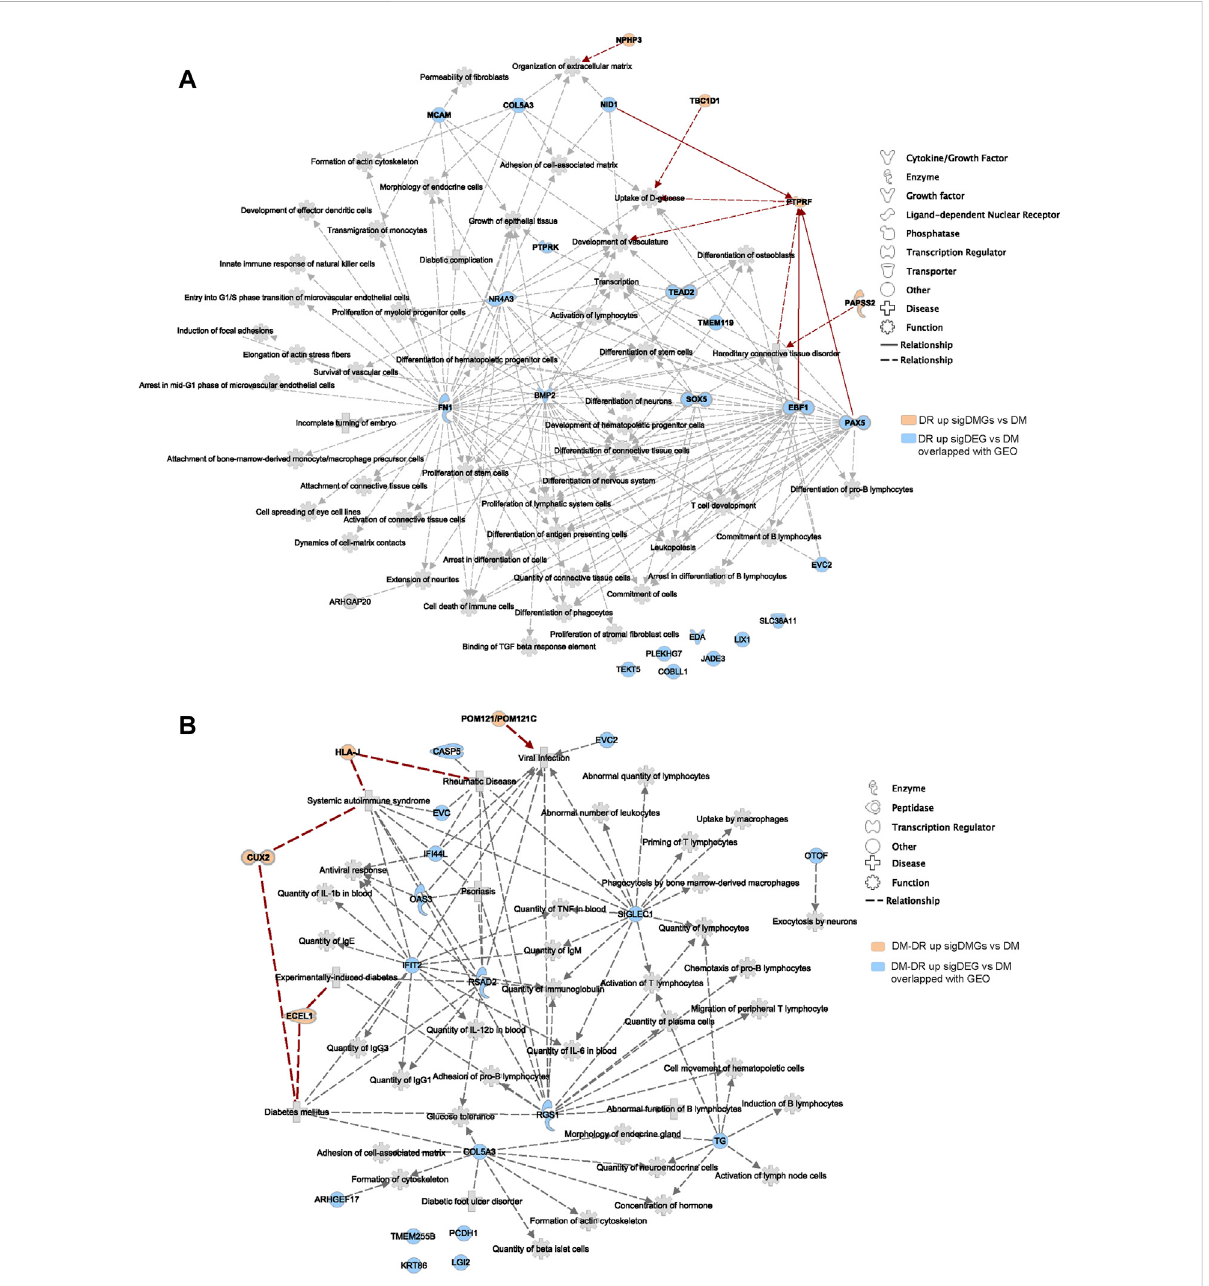
FIGURE 6 Disease and function network of upregulated differently expressed genes (DEGs) veri fi ed by Gene Expression Omnibus (GEO) data of patients withdiabeticretinopathy(DR). (A) thediseaseandfunctionanalysisusingingenuitypathwayanalysissoftwareoftheoverlappedupregulatedDEGsof DR vs. non-DR (DM) and GEO datasets, including GSE102485, GSE94019, and GSE60436, and the direct and indirect interactions with the putatively susceptibledifferentiallymutantgenes(DMGs)ofDRvs.DM. (B) theintersectionanalysisoftheoverlappedupregulatedDEGsofDM – DRvs.DM with GEO datasets and the enriched DMGs of DM – DR vs.